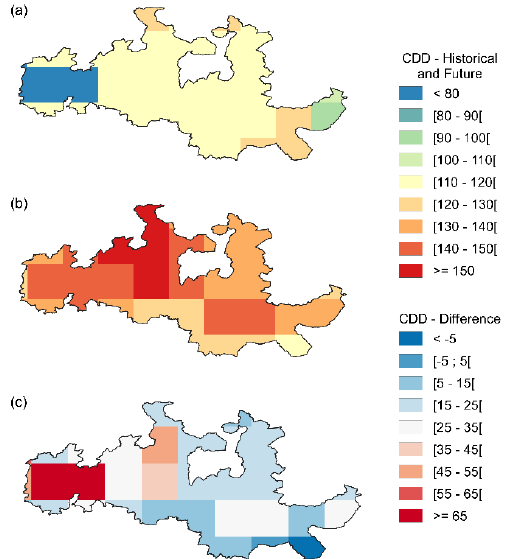
Figure 11. Ensemble-mean of the Consecutive Dry Days Index (CDD) for the Douro Wine Region, bias-corrected by quantile mapping, for the ( a ) historical (1989–2005), ( b ) future (2051–2080) under the RCP8.5, and ( c ) future historical difference.